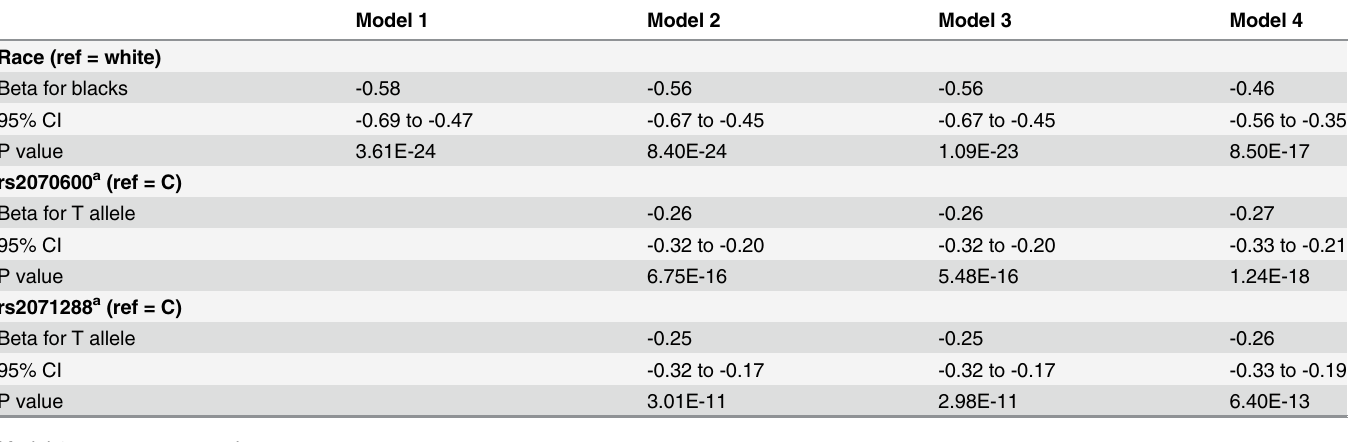
Model 1: age + race + gender + center Model 2: Model 1 + rs2070600 + rs2071288 Model 3: Model 2 + education Model 4: Model 3 + BMI, eGFR, fasting glucose, prevalent CHD a Beta for difference in ln(sRAGE) for T vs. C